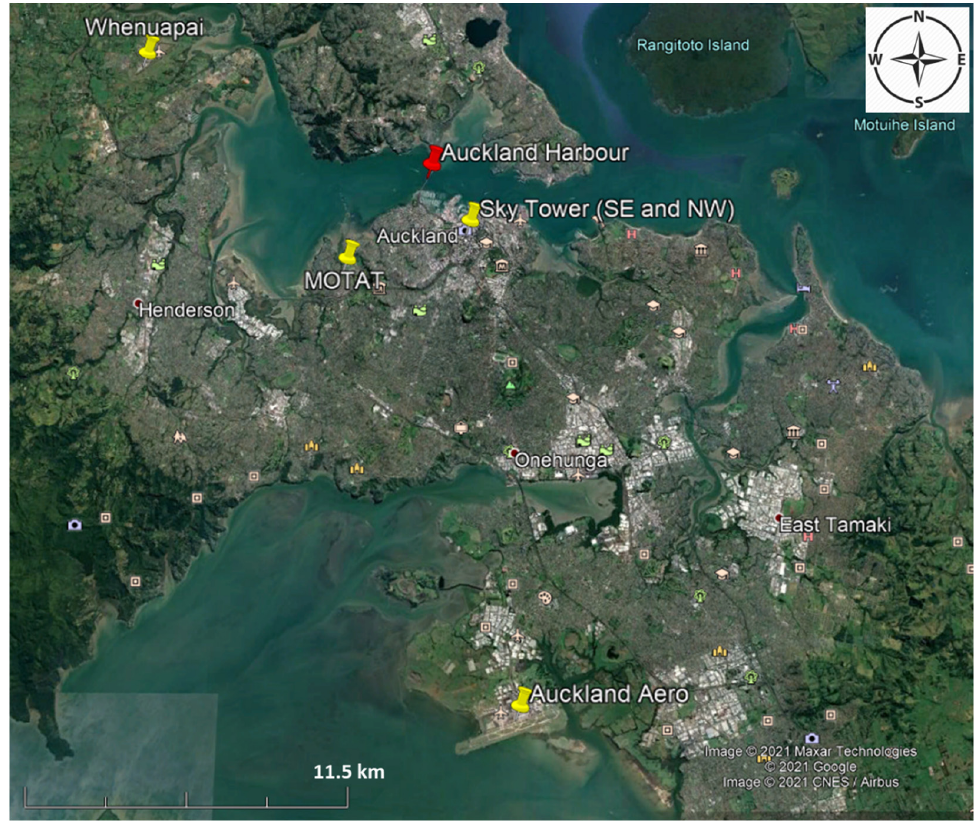
Figure 2. Locations of the measurement sites (yellow pins) used for the validation of the NWP outputs. The red pin shows the location of the Auckland Harbour Bridge. The aerial image is from Google Earth. Table 1. List of the measurement stations used for validation along with their coordinates and heights above the ground surface.